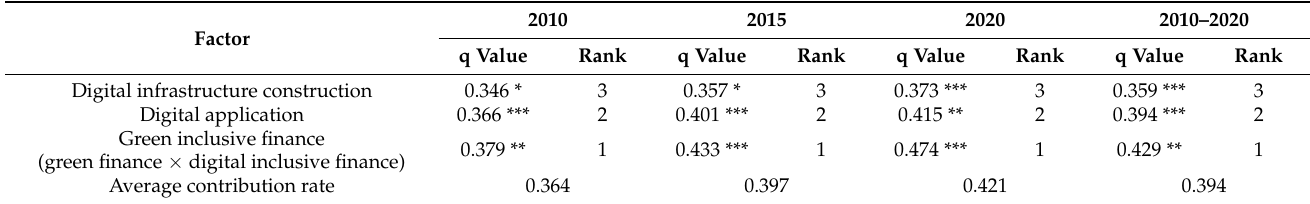
Table 5. Detection results of global digital drivers from 2010 to 2020.